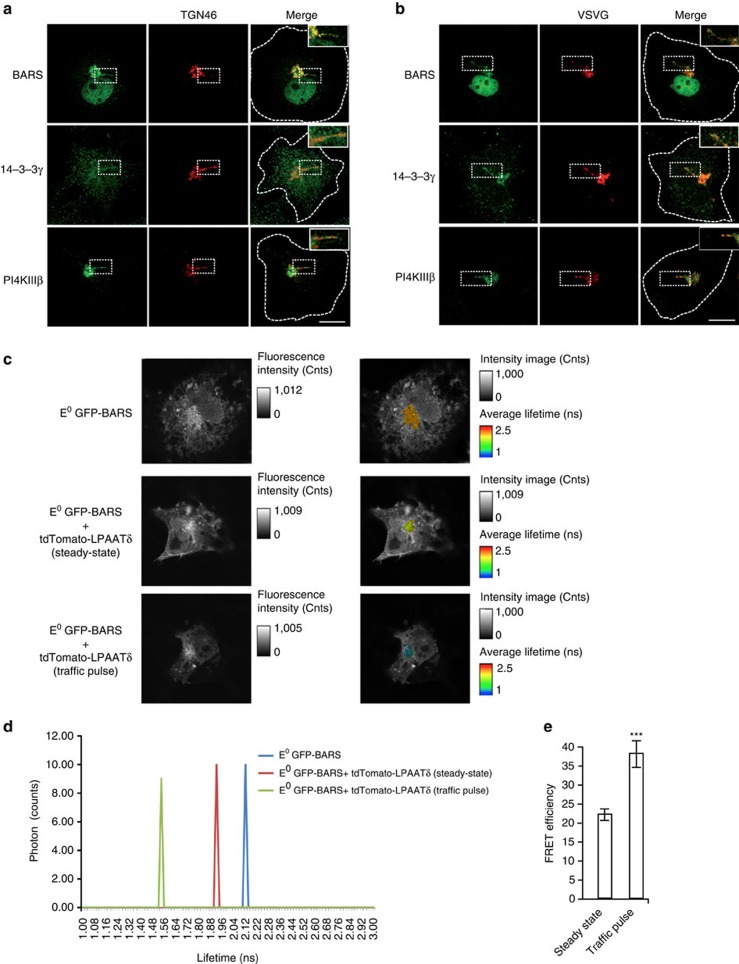
BARS colocalizes with 14-3-3γ and PI4KIIIβ at the TGN and in carrier precursors and interacts with LPAATδ at the Golgi.(a,b) Representative images of COS7 cells at steady state in a, or VSV-infected and subjected to the VSVG TGN-exit assay in b. The cells were fixed and labelled with polyclonal anti-BARS, anti-14-3-3γ or anti-PI4KIIIβ (a,b; green) antibodies, and with an anti-TGN46 antibody (a; red) or a monoclonal anti-VSVG antibody (b; red). Insets, right: magnification of the tubular carrier precursors in the Golgi area. Dotted lines indicate cell borders. Scale bars, 10 μm. (c,d) Pixel-by-pixel FLIM analysis and photon distributions of COS7 cells transfected with E0GFP–BARS alone or in combination with tdTomato-LPAATδ and fixed at the steady state or during the traffic pulse (as indicated). (c) The shortening of E0GFP–BARS donor lifetime in the presence of the tdTomato-LPAATδ acceptor due to FRET is lower in the steady-state fixed cell (where a basal interaction between the two proteins occurs) and is higher, as indicated by the blue pixels, in the traffic pulse cell (fixed after 10 min of the 32 °C temperature-release block, see Methods) where the interaction between the two proteins is quantitatively increased (see also Supplementary Fig. 8). (d) Representative photon-counting events during the time of the donor E0GFP–BARS fluorescence emission, measured in pixels containing >300 photons in the Golgi area, when overexpressed alone (blue) or with tdTomato-LPAATδ under steady-state (red) or during traffic pulse (green) conditions. The average fluorescence lifetime of E0GFP–BARS were 2.08±0.07 ns (E0GFP–BARS alone), and 1.62±0.22 ns and 1.28±0.27 ns (with tdTomato-LPAATδ) under steady-state or during traffic pulse conditions, respectively. (e) Quantification of FLIM-FRET efficiency in the Golgi area under steady-state or during a traffic pulse conditions (as indicated). Data are mean±s.d. (n=10 cells per condition). ***P<0.005 (Student's t-tests) versus steady state.